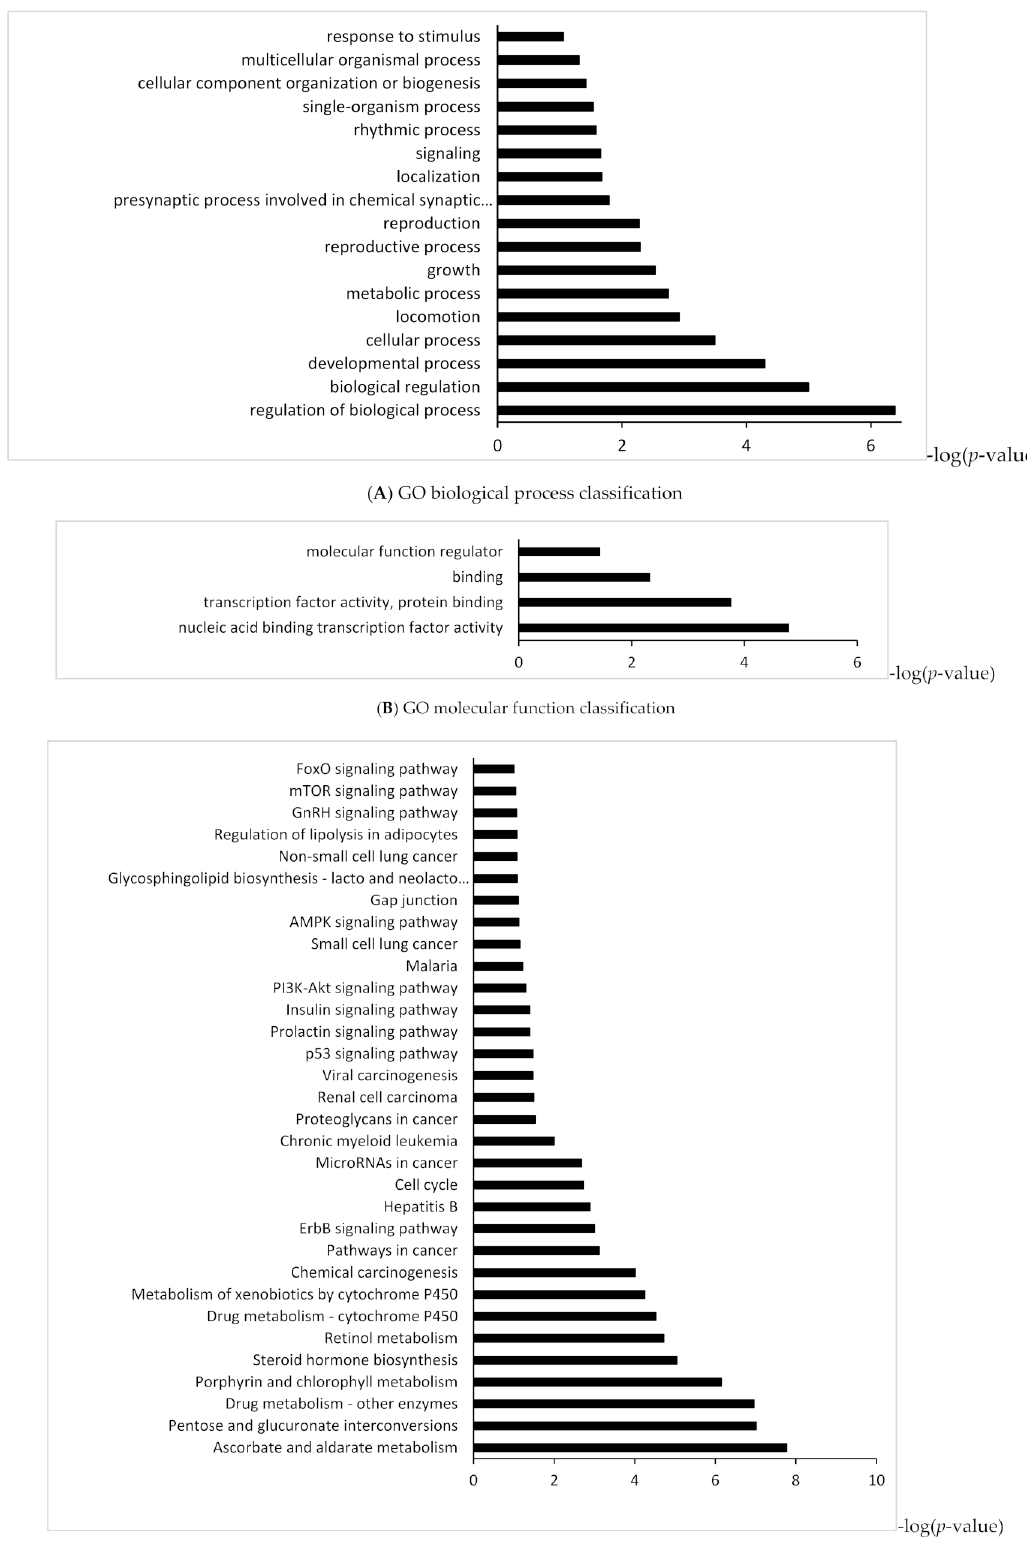
Figure 3. Gene Ontology and KEGG enrichment analysis of target genes of down-regulated miRNA in vitreous of high myopic MH